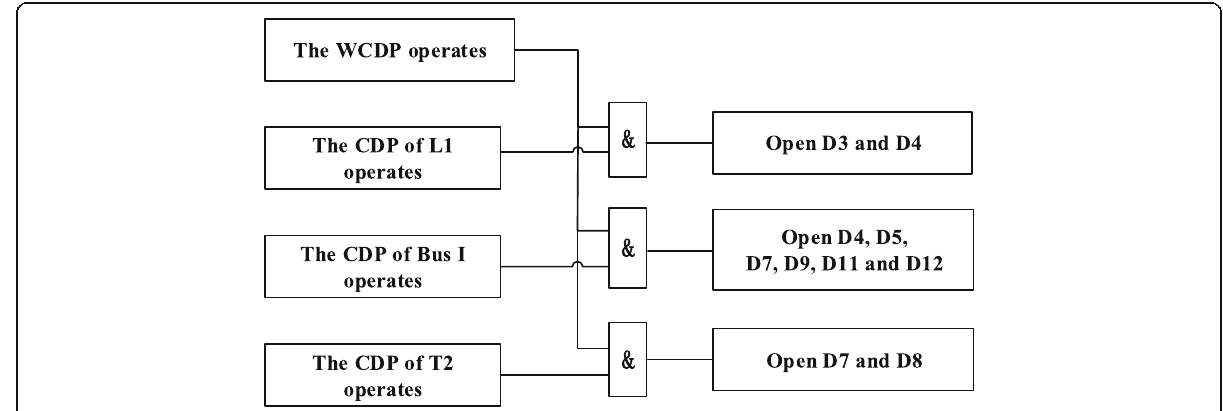
Fig. 4 The logical relationship between the WCDP and